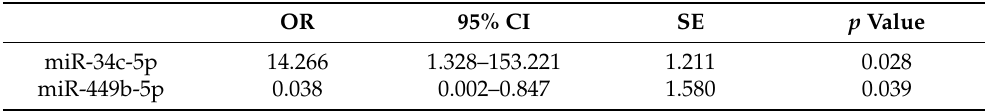
Table 11. Odds Ratio (OR), confidence interval (95% CI) and standard error (SE) of logistic regression to evaluate the association between viable embryo and the expression of miR-34c-5p and miR-449b-5p (dependent variable: non-viable embryos).